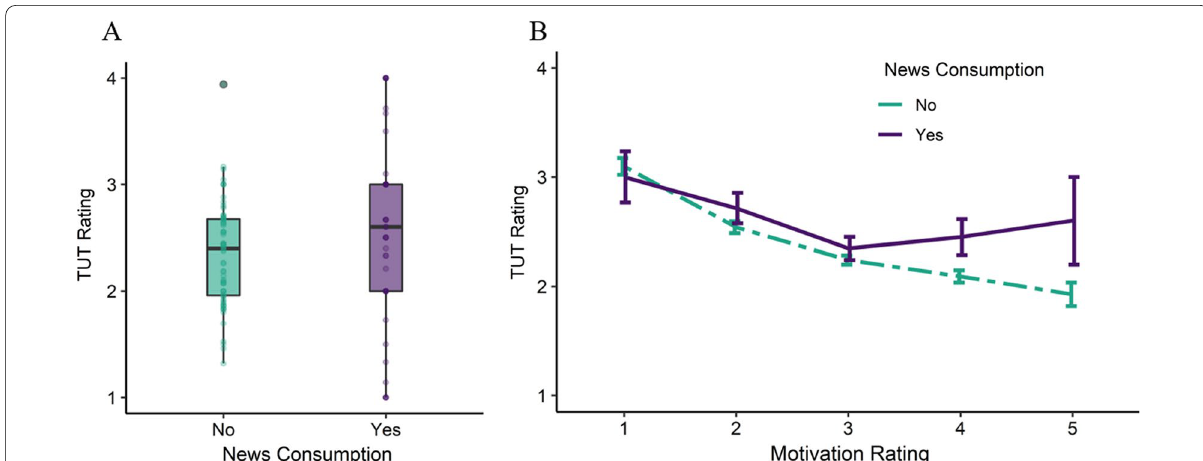
Fig. 2 Relationship Between Task‑Unrelated Thought Ratings and General News Consumption (Study 2). Note Task‑unrelated thought (TUT) ratings (1 completely on‑task to 4 completely off‑task) are shown as a function of general news consumption (panel A ) and an interaction of = = motivation ratings and general news consumption (panel B ) which was not significant, from Study 2. Panel A : boxplots are of average TUT ratings when participants did and did not consume general news media; individual averages shown as dots. General news consumption (“Yes”; shown in purple/darker color) was associated with higher ratings of TUT compared to the absence of general news consumption (“No”; shown in green/ lighter color). Panel B : line graph of average TUT ratings when participants did and did not consume general news media at different levels of task motivation (1 not motivated at all to 5 extremely motivated). Error bars represent the standard error of the mean. The association between TUT = = and general news consumption did not significantly vary as a function of task